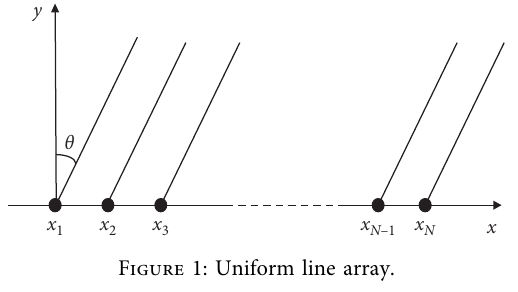
Figure 1: Uniform line array.